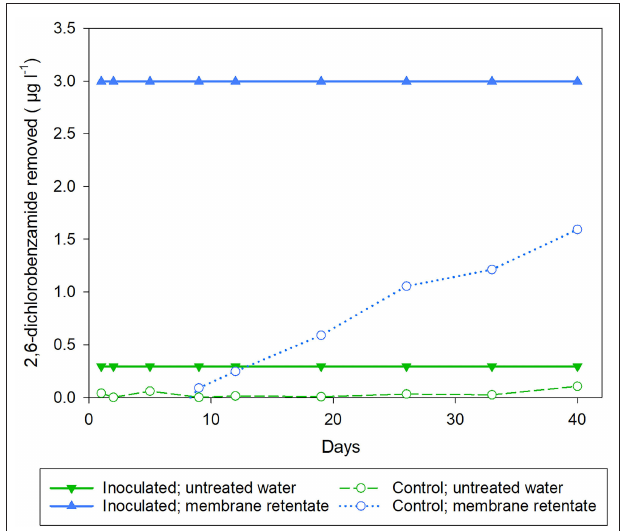
FIGURE 1 | Amount of 2,6-dichlorobenzamide (BAM) removed in the columns. Triangles represent columns inoculated with BAM-degrader Aminobacter sp. MSH1, while circles represent control columns. Columns received as feed either untreated water with 0.3 µ g l − 1 BAM (green) or membrane retentate water with 3.0 µ g l − 1 BAM (blue).